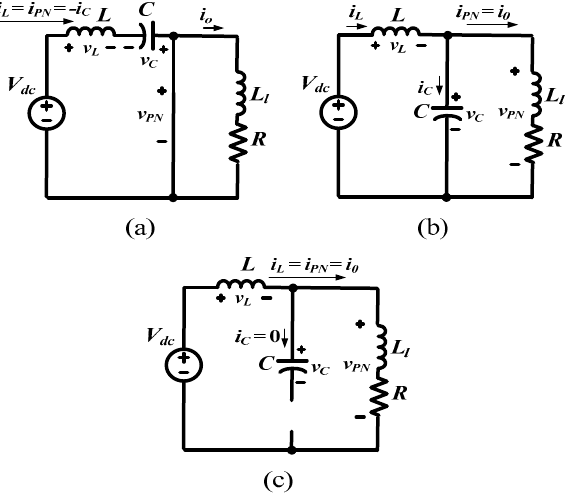
Figure 3. Operating states of qSBI type 2 under small shoot-through duty cycle; ( a ) shoot-through; ( b ) non-shoot-through when i L > i PN and ( c ) non-shoot-through when i L = i PN